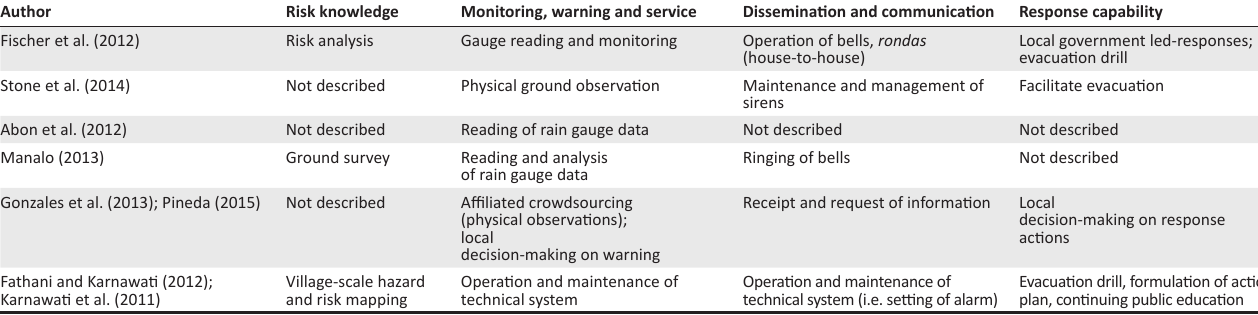
TABLE 1: Summary of local participation in five operational community-based early warning systems.